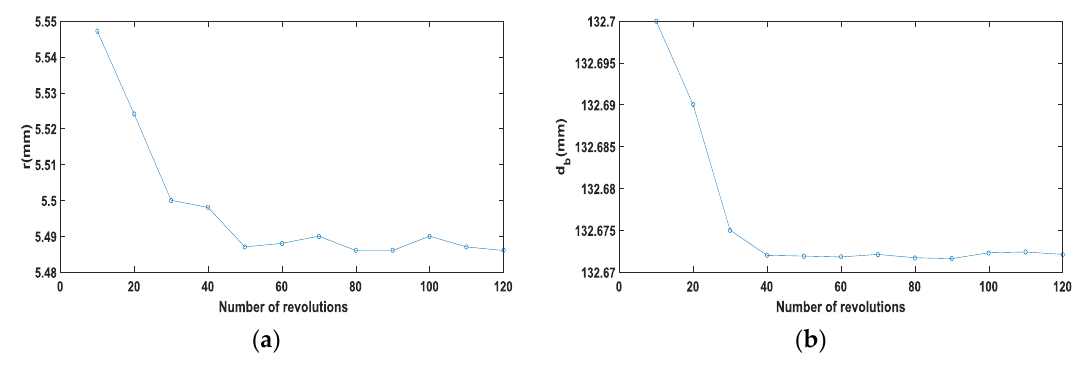
Figure 8. Experiment physical map.